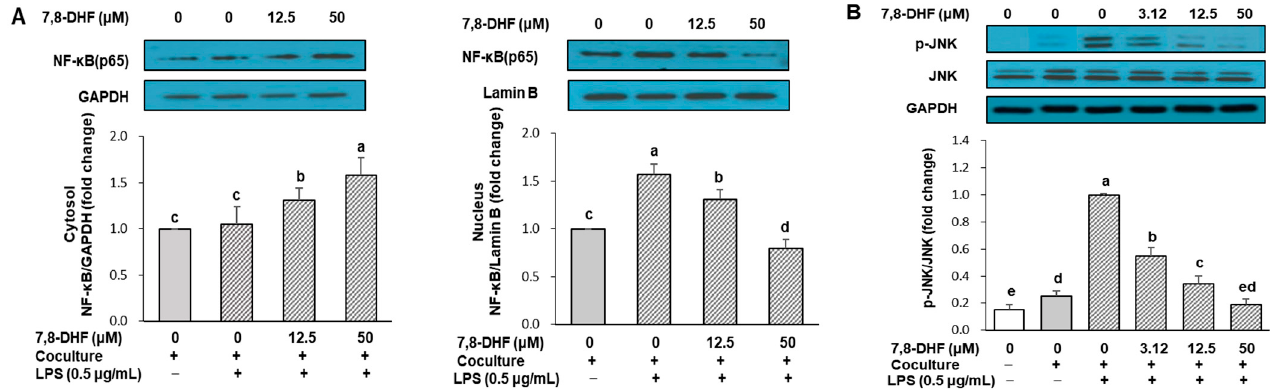
Figure 4. Effect of 7,8-DHF on NF- κ B signaling ( A ) and JNK activation ( B ) in coculture of adipocytes and macrophages. Hypertrophied 3T3-L1 adipocytes were cocultured with RAW 264.7 macrophages for 24 h. Cells were treated with 7,8-DHF for 24 h and then stimulated with LPS (0.5 μ g/mL) for 30 min. Cytosolic ( left panel , A ) and nuclear levels ( right panel , A ) of NF- κ B p65 subunit were measured to estimate the translocation of NF- κ B for activation. Expression of JNK and phosphorylated JNK were measured from total cell lysates by Western blotting. Values are mean ± SD of three independent experiments. Means without the same letters are significantly different by ANOVA, followed by Duncan’s test ( p < 0.01). Coculture +: adipocytes were cocultured with macrophages, coculture − : adipocytes and macrophages were separately cultured and mixed before the assay. Cells were stimulated with LPS (0.5 μ g/mL LPS +) or not (0.5 μ g/mL LPS − ). 7,8-DHF, 7,8-dihy-